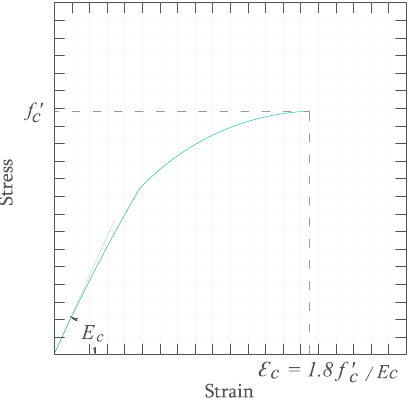
Figure 3. Modified Hognestad model for concrete [33]